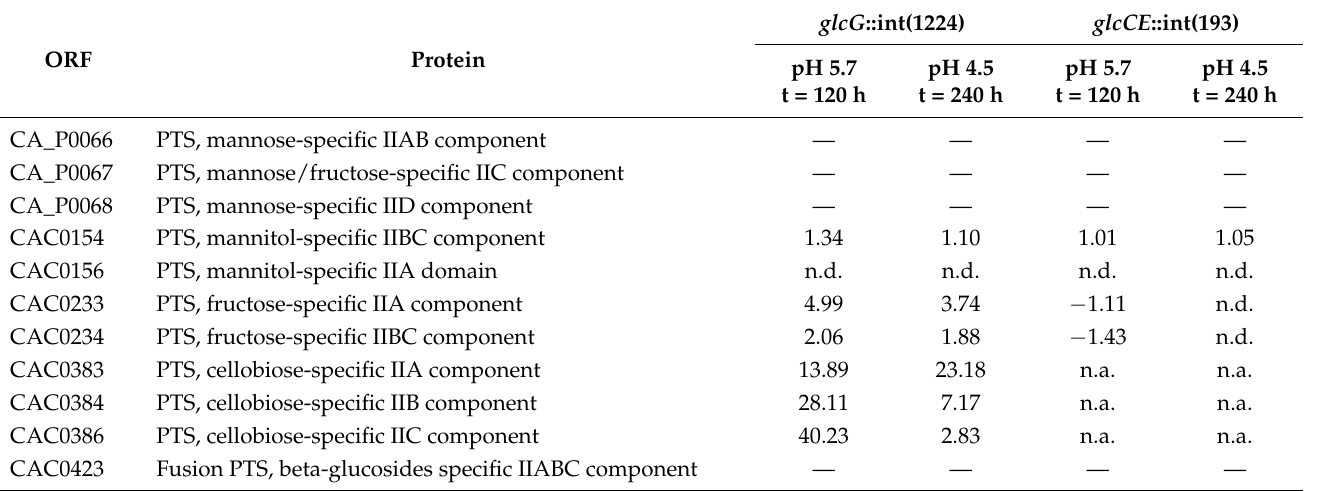
Table 1. Transcriptional profiles of all the PTS enzyme II protein genes of mutants C. acetobutylicum glcG ::int(1224) and glcCE ::int(193) compared to the wild